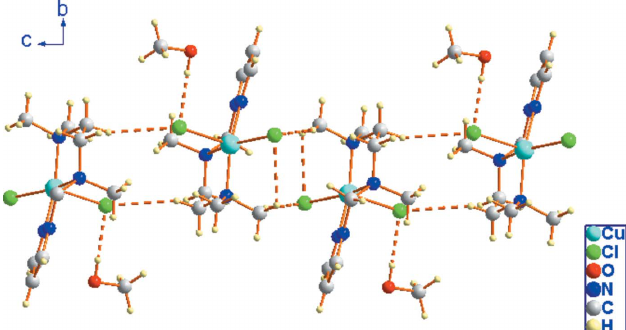
Figure 3 The crystal packing of the title compound, viewed along the a axis.